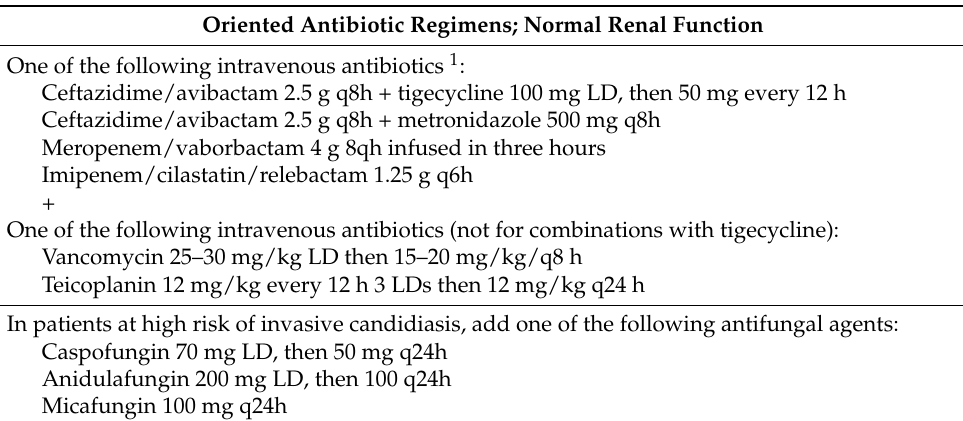
Table 5. Patients with IAIs with known colonisation (infection) by KPC-producing Enterobacterales . Oriented Antibiotic Regimens; Normal Renal